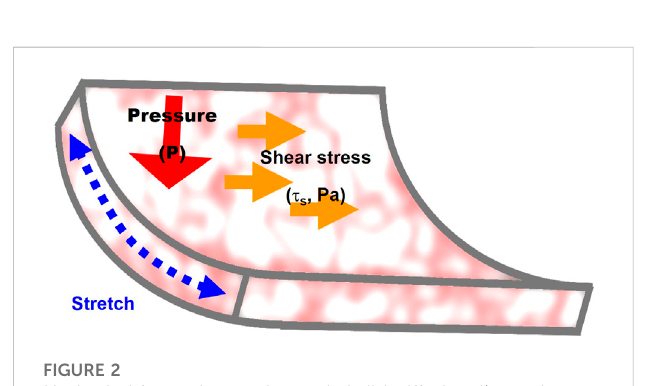
FIGURE 2 Mechanical forces that regulate endothelial stiffening: 1) stretch generated by contraction/relaxation of the arterial wall, 2) fl uid shear stress, a frictional force generated by the blood fl ow, and 3) hydrostatic pressure. The mechanisms involved in the effects of the three forces on endothelial stiffness are described in Section 3 of the